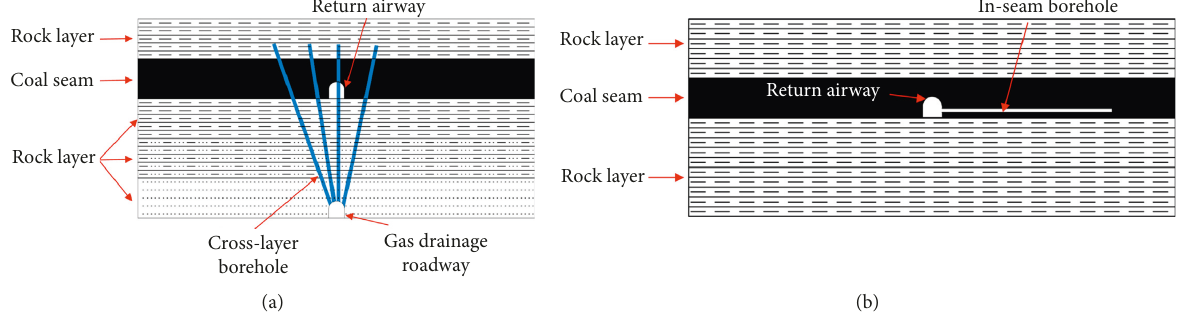
Figure 5: Layout of the boreholes: (a) cross-layer boreholes; (b) in-seam borehole.